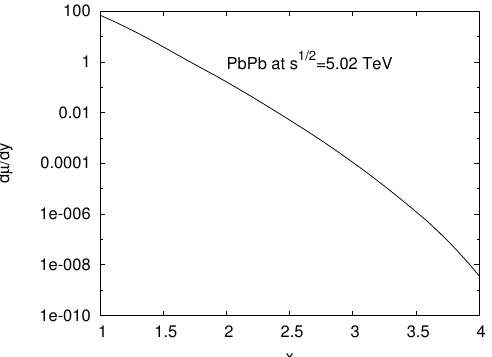
Figure 9. Total multiplicities per unit rapidity for production of cumulative pions at cumulatively x ≥ 1 in Cu–Cu and Au–Au–Au collisions at 200 GeV.